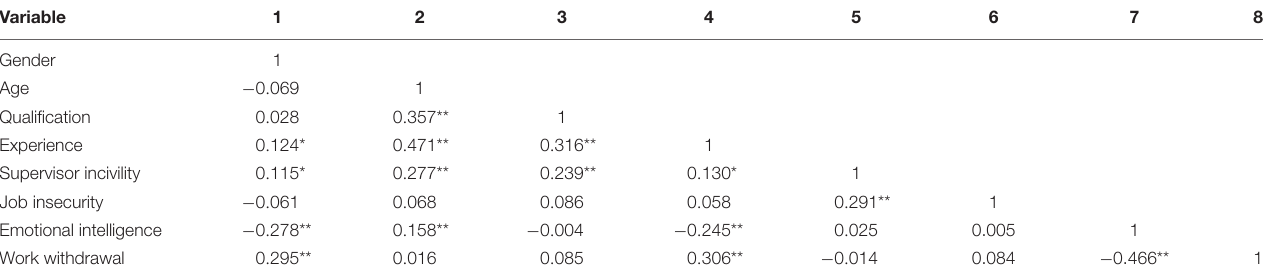
TABLE 5 | Correlation analysis.